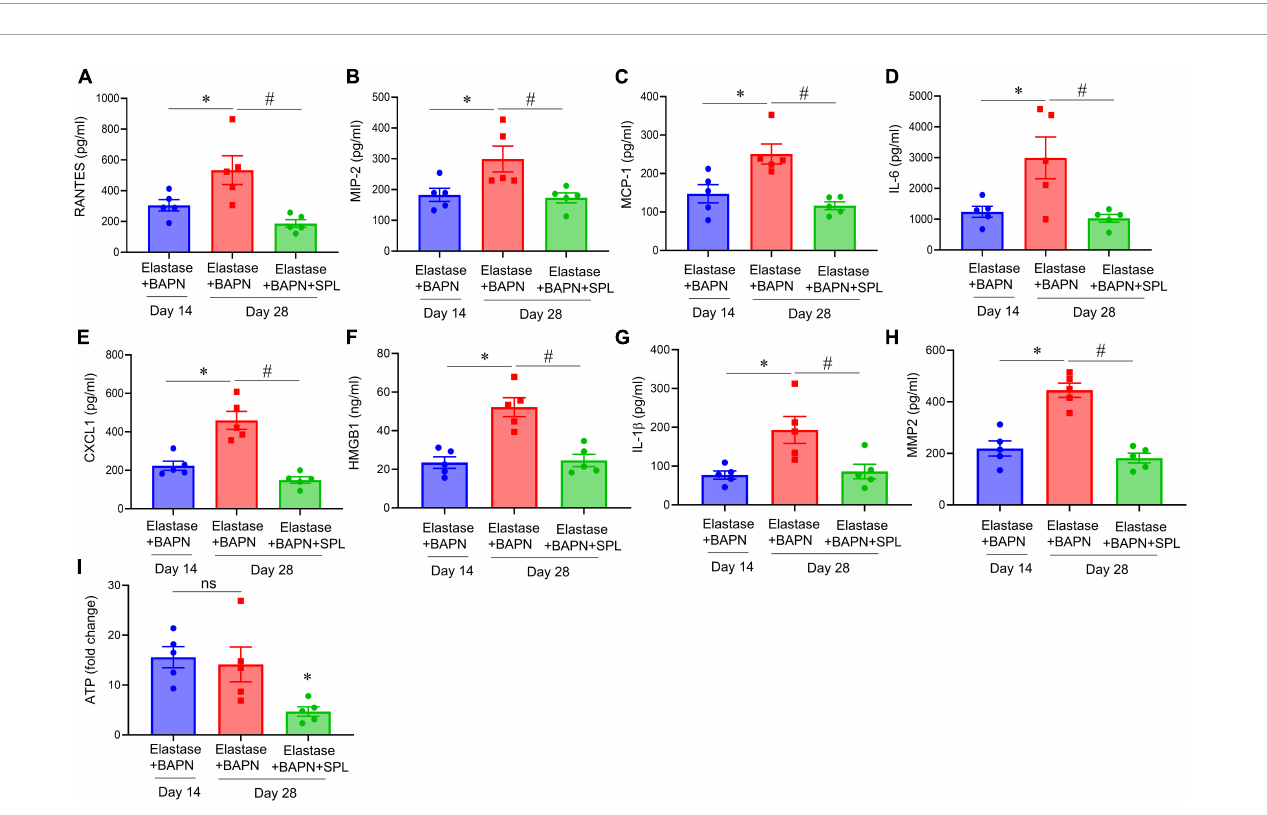
FIGURE6 Spironolactone inhibits aortic inflammation and vascular remodeling during chronic AAA formation. (A–G) Cytokine expression in aortic tissue is significantly decreased in elastase + BAPN-treated mice after SPL administration compared to untreated mice. ∗ P < 0.04; # P < 0.02; n = 5/group. (H) MMP2 activity was significantly attenuated in SPL-treated mice compared to elastase-treated mice alone. ∗ P < 0.01; # P < 0.001; n = 5/group. (I) ATP content was decreased in SPL-treated mice compared to untreated mice. ns, not significant; ∗ P < 0.01; n = 5 mice/group.